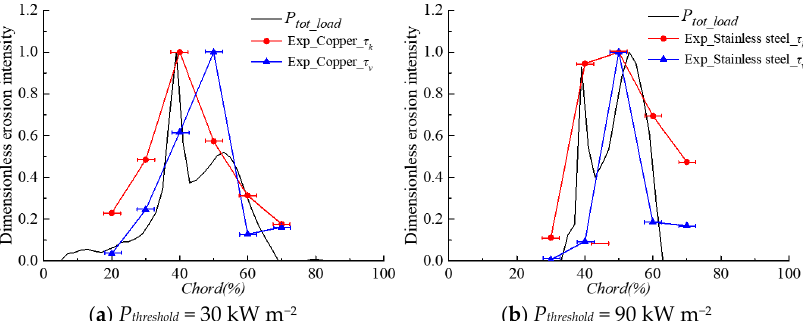
Figure 14. Comparison of dimensionless erosion intensity indicators between numerical and experimental results. experimental